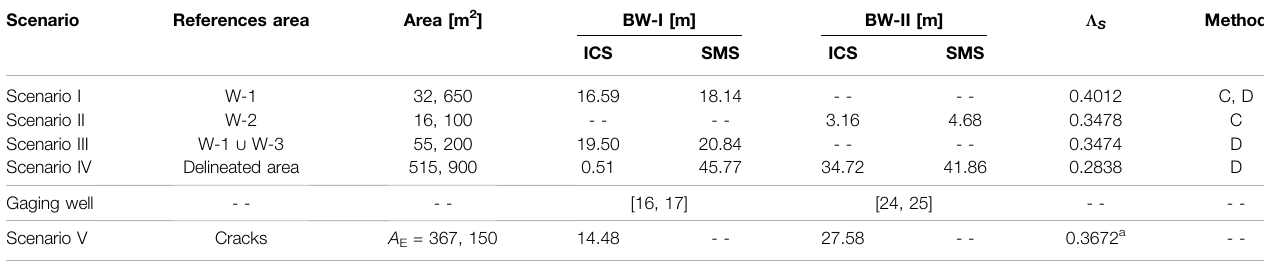
TABLE 4 | Scenarios for Taitung-Yanping-T003.